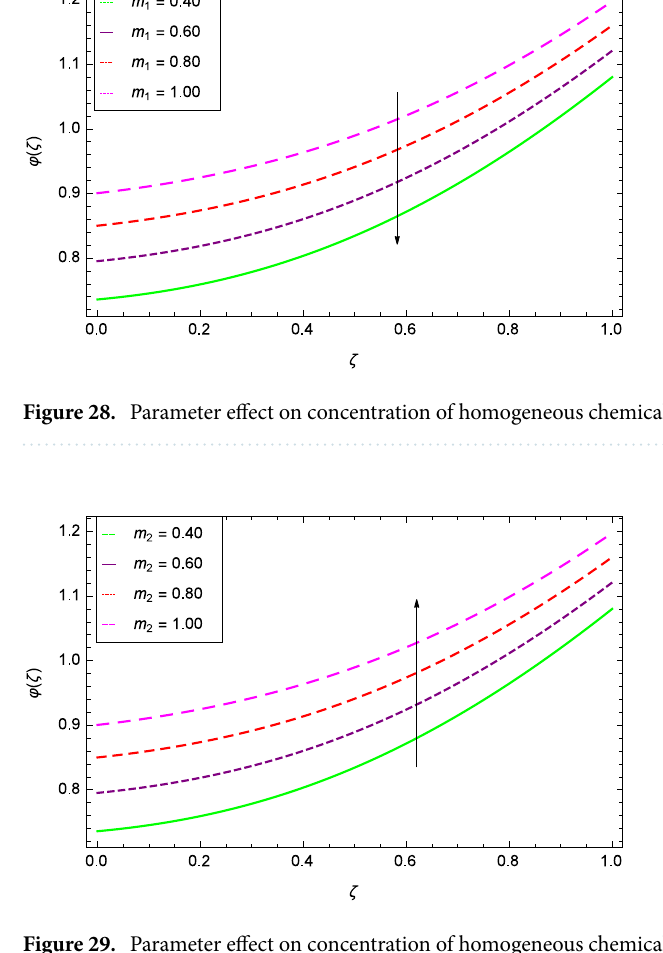
Figure 29. Parameter effect on concentration of homogeneous chemical reactions ϕ ( ζ ) profile.